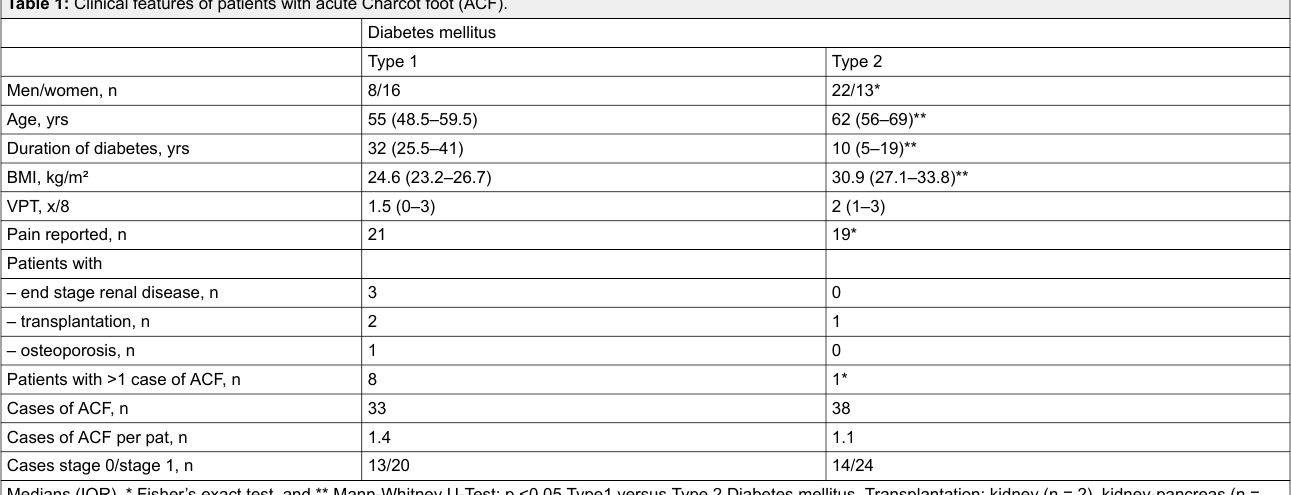
Table 1: Clinical features of patients with acute Charcot foot (ACF).